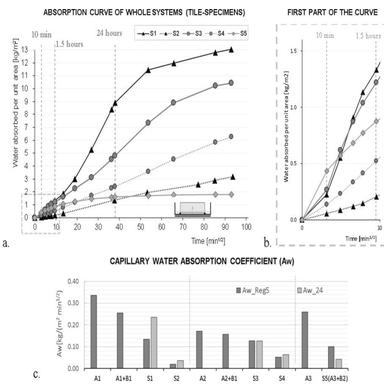
Capillary water absorption, results obtained with tile samples.